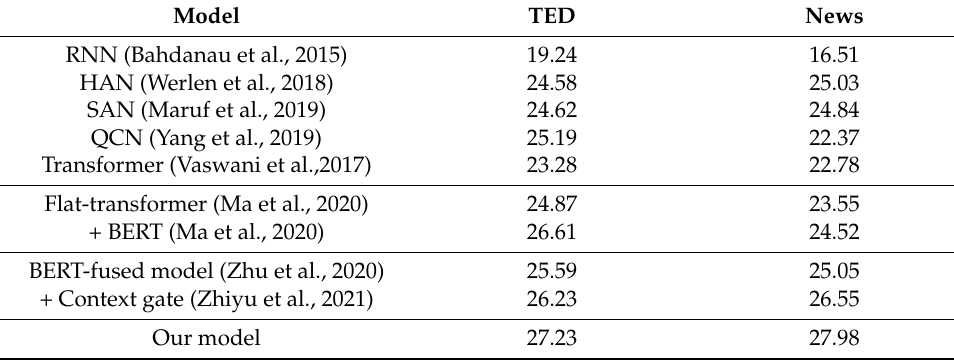
Table 5. BLEU scores of two document-level machine translation